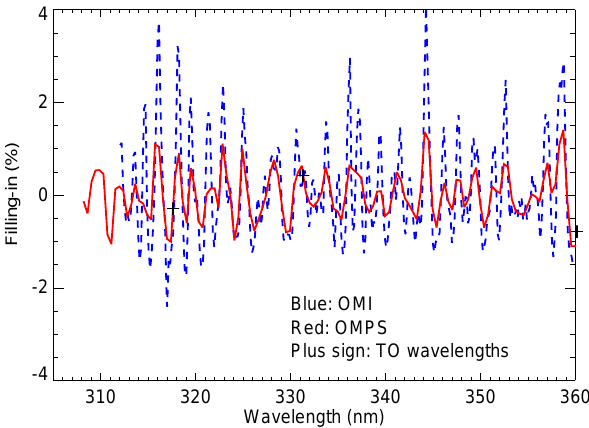
Figure 1. Comparison of OMI and OMPS RRS filling-in. Plus signs show the wavelengths used in the OMPS total ozone (TO) algo-